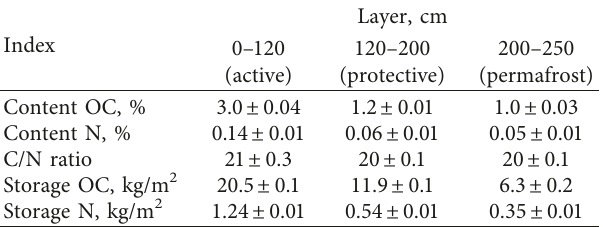
Table 2: Characteristics of soil organic matter: the distribution of stocks and the average organic carbon (OC) and nitrogen (N) content in the elementary layers of the ice